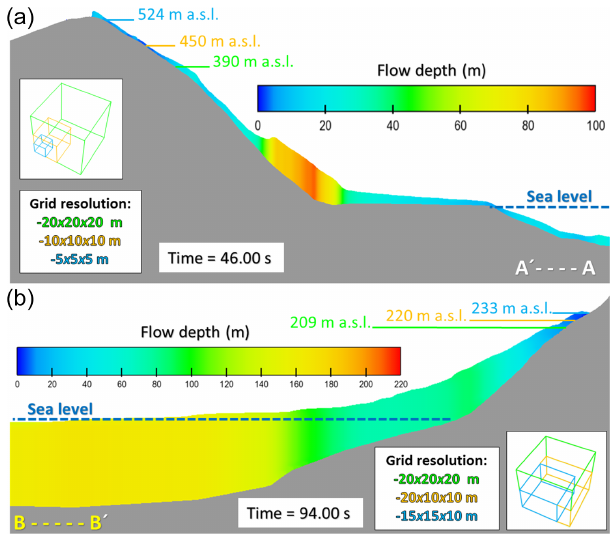
Figure 13. Maximum wave run-up resulting from different grid res- olutions (see the cross section in Fig. 12). (a) In the impact area the maximum resulting run-up of 524ma.s.l. relates to the 5m uniform mesh size. (b) The maximum wave run-up results in 233ma.s.l. for a non-uniform mesh size of 15m × 15m × 10m at Mudslide Creek (observed run-up was